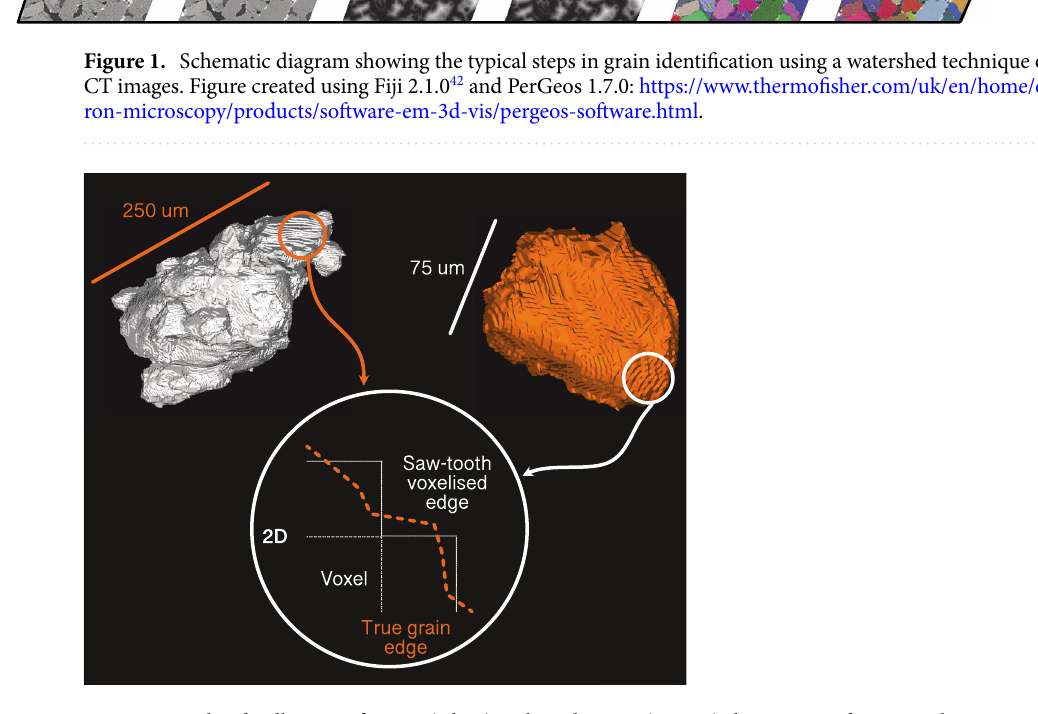
Figure 2. Isolated collection of grains (white) and single grain (orange) shown in 3D from sample SF696. The saw-tooth or staircase pattern is highlighted which arises from the voxelised images. This can lead to overestimation of surface area and impact the subsequent sphericity measurements. Figure created using Fiji 2.1.0 42